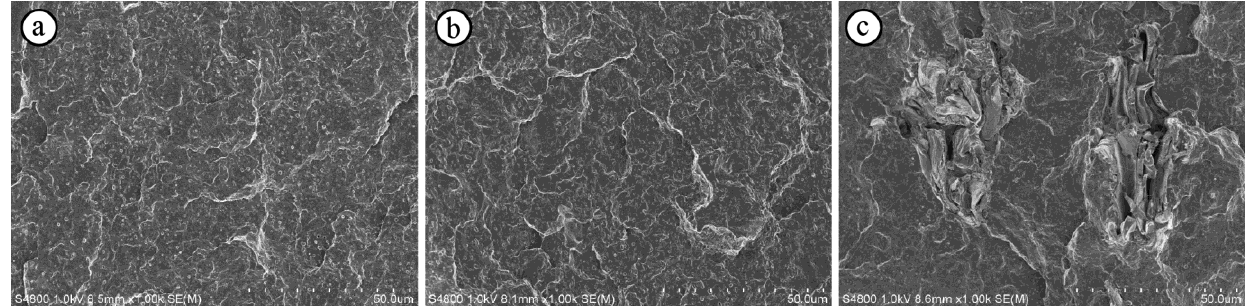
Figure 7. Scanning electron micrographs of fractural surfaces after the impact tests of the specimens of the ( a ) PP/EBC blend (90/10) and the ( b ) LCNF and ( c ) wood flour composites. The wood flour and LCNF contents of the composites were 10